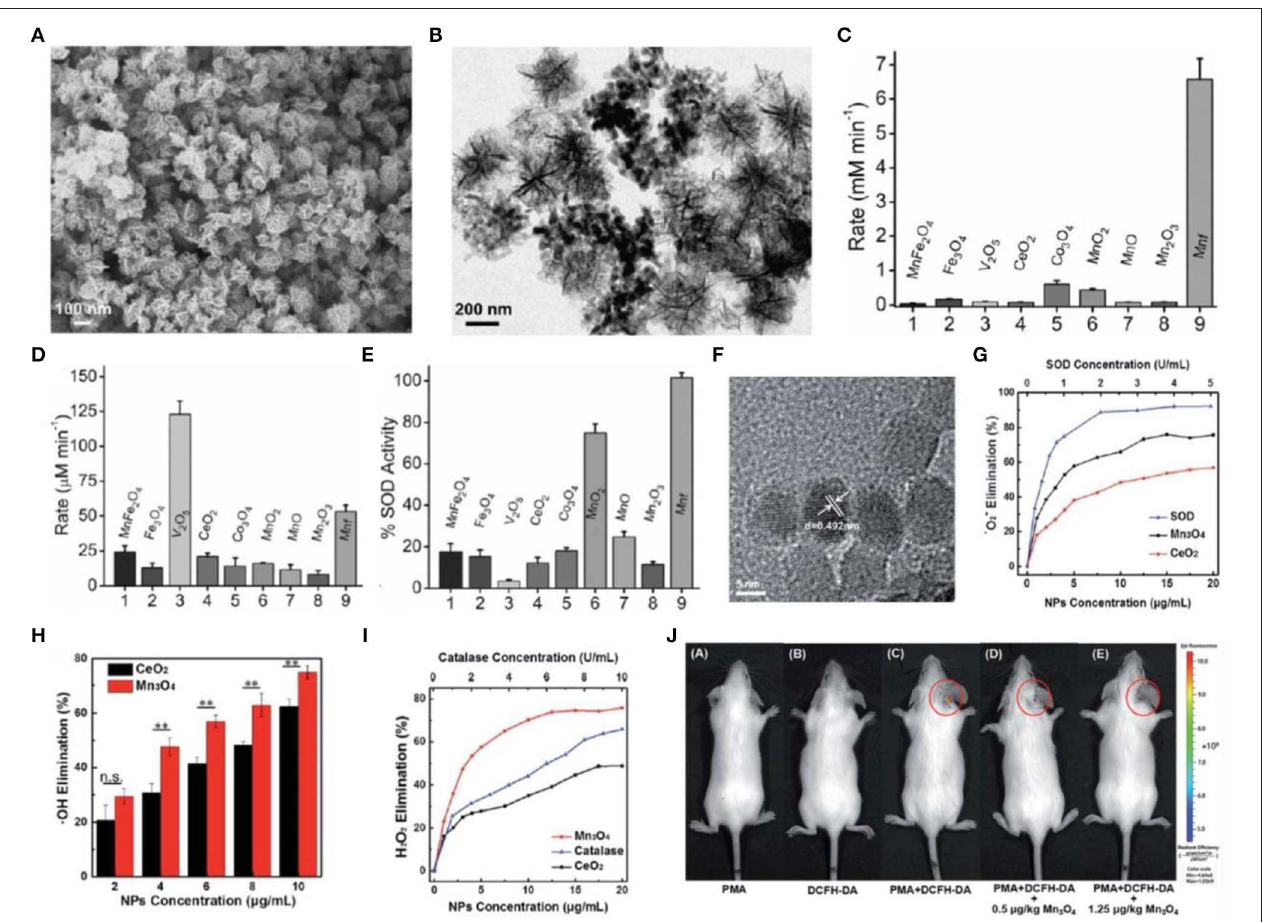
FIGURE 2 | Characterization and antioxidative activity of manganese-based nanoparticles. (A,B) Scanning electron microscopy (SEM) (A) and TEM (B) images of Mn 3 O 4 nanoparticles with flower-like morphology (Mnf). (C–E) A comparison of CAT (C) , glutathione peroxidase (D) , and SOD (E) -like activity of Mnf with other metal oxide nanoparticles. (F) TEM image of Mn 3 O 4 nanoparticles synthesized via a hydrothermal method. (G–I) Dependence between the elimination of • O 2 − (G) , • OH (H) , H 2 O 2 (I) and concentrations of Mn 3 O 4 and CeO 2 nanoparticles. (J) In vivo fluorescence imaging of mice with PMA-induced ear inflammation after treatment with Mn 3 O 4 nanoparticles. Images in (A–E) are reproduced with permission from Singh et al. (2017). Images in (F–J) are reproduced with permission from Yao et al.